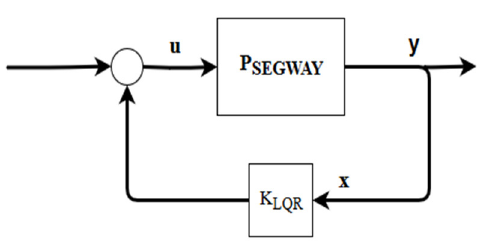
Fig. 5: Block Diagram of LQR Controller for the System (Segway)